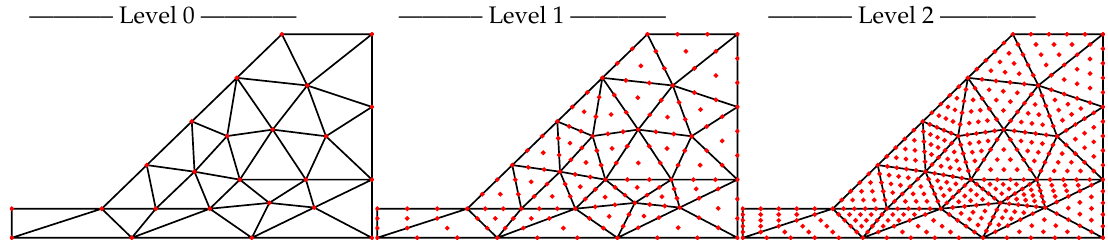
Figure 4. p-refined hierarchy of meshes used for model problem